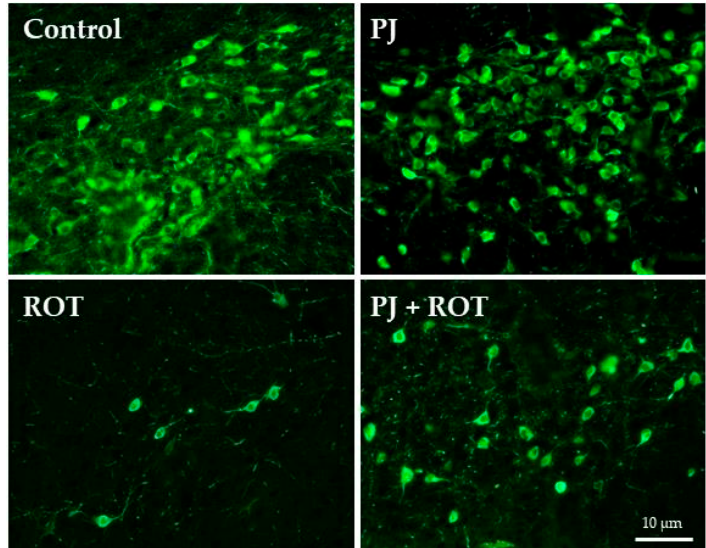
Figure 4. Representative photomicrographs of immunofluorescent staining of TH-positive cells in adjacent microtome sections of substantia nigra (SN) neurons. Rotenone (ROT) administration caused the substantial loss of TH + neurons, as compared to a control rat (control). Administration of pomegranate juice attenuated this loss (PJ + ROT). The pomegranate juice application (PJ) itself did not cause any e ff ect on TH + cells survival when compared to control rats. Scale bar—10 µ